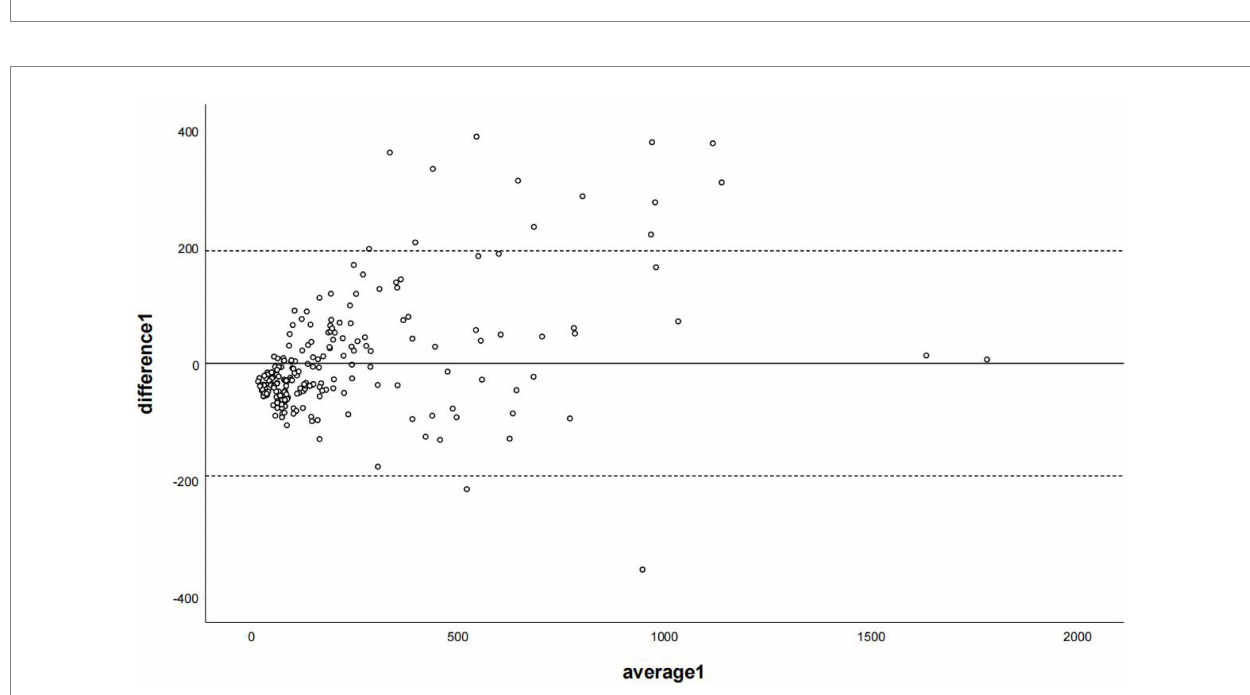
FIGURE 6 The Bland–Altman plot was used to describe the agreement of coronary artery calcium scores between the non-contrast images and virtual non- contrast images (the sum of calcium scores was corrected using the corresponding linear regression equation of each coronary branch). Average 1 represented the mean value of calcium score from two images, and difference 1 represented the different values of calcium score from two